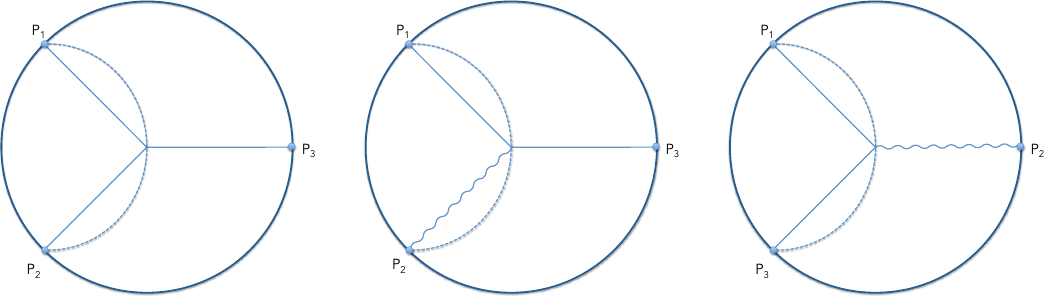
Figure 3 . Examples of geodesic Witten diagrams in AdS d +1 that capture three point functions. Straight lines correspond to scalar propagators, while wavy lines denote symmetric traceless spin- J (cid:12)elds; P i is the boundary position in embedding formalism. The dotted line denotes the geodesic over which we integrate. Note that the second and third diagram only di(cid:11)er by the choice of